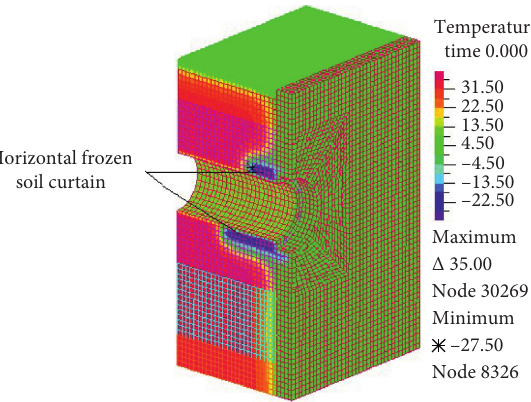
Figure 3: Frozen soil curtain after 50 days’ freezing time.